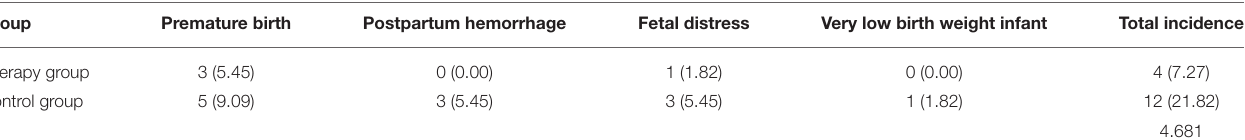
TABLE 2 | Comparison of adverse reactions between the two groups ( n = 55, %).